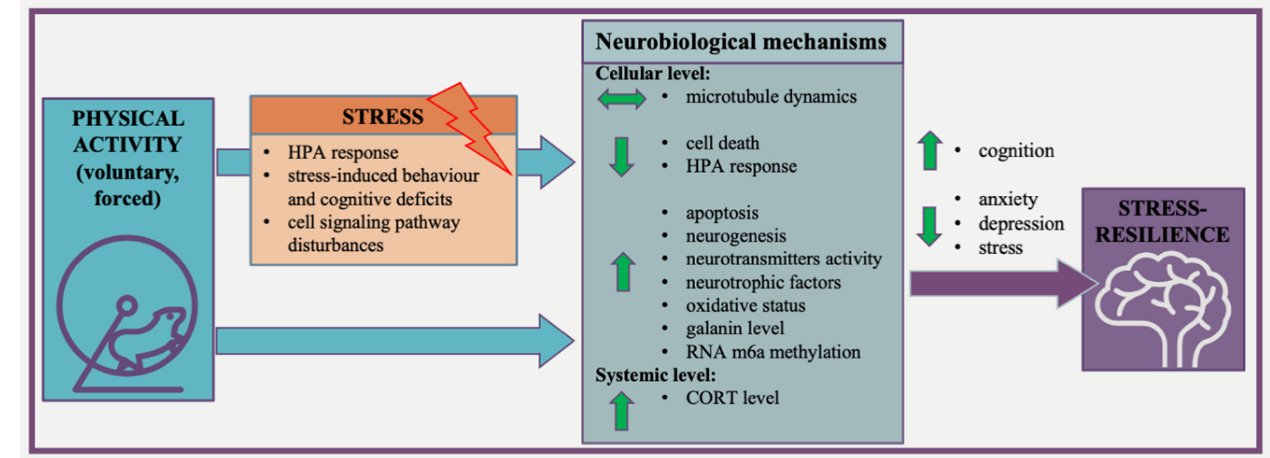
Figure 2. The proposed mechanisms involved how exercise can promote the development of the stress-resilient phenotype brain resilience.